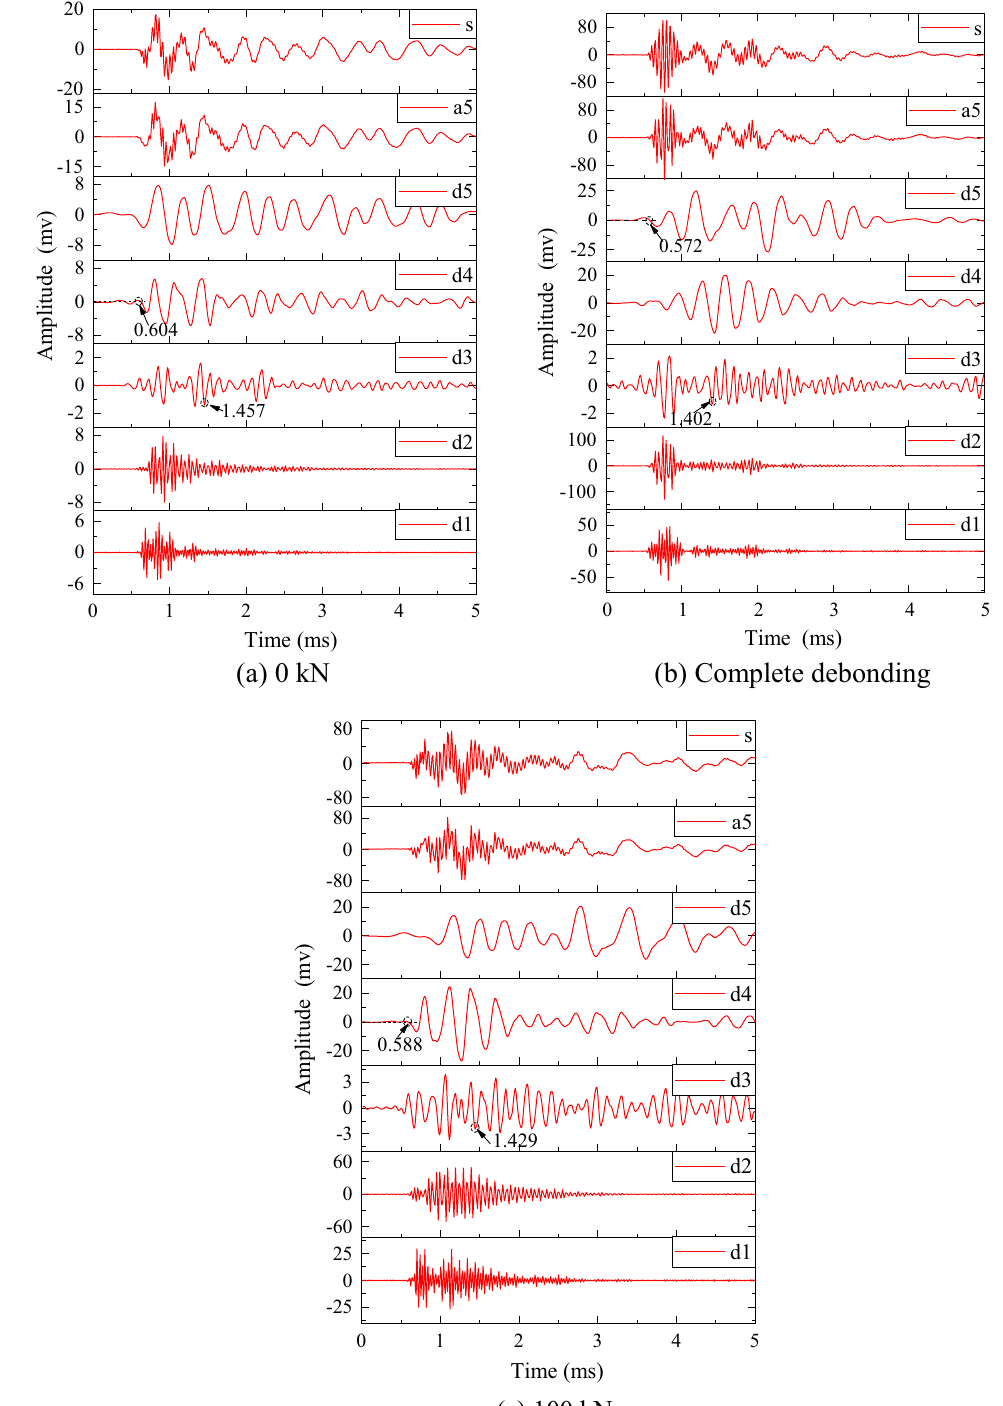
Fig. 3 Wavelet multi-scale decomposition of guided wave signals in rockbolt under different pull-out